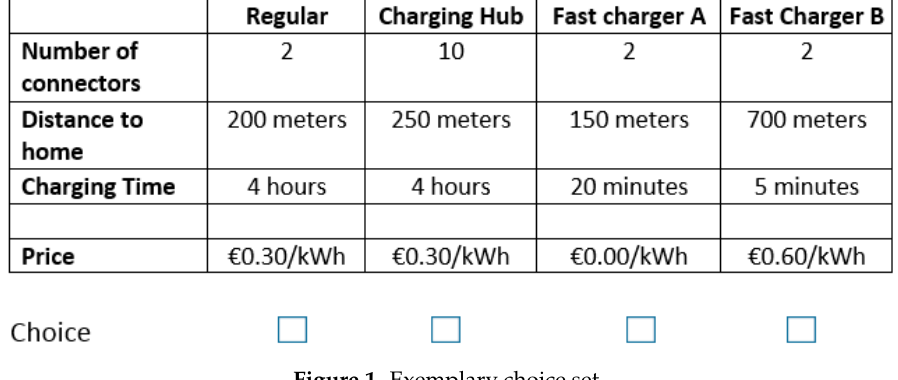
Figure 1. Exemplary choice set.